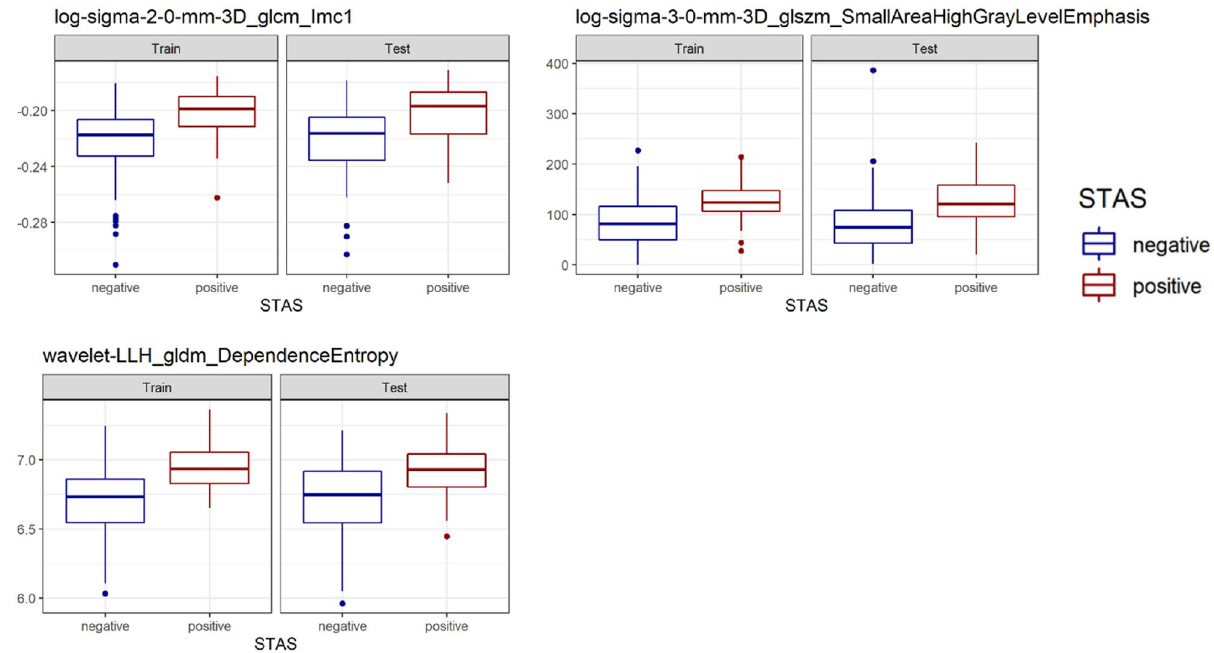
Figure 5. Values of features used in peritumoral radiomics model in training/test